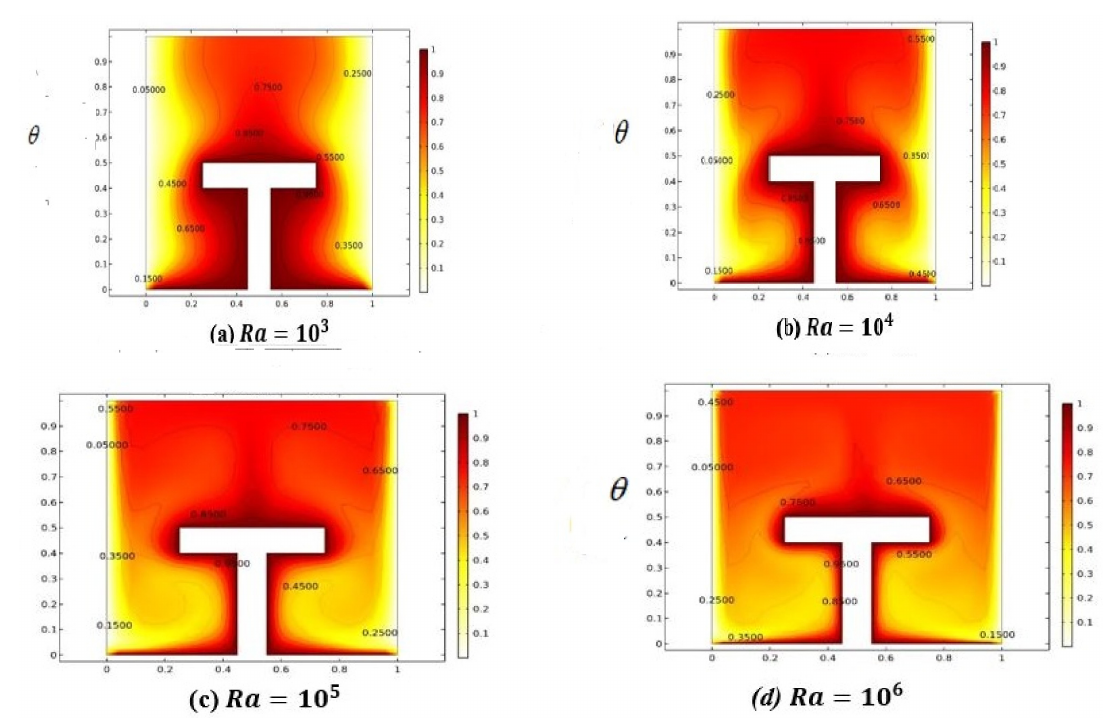
Figure 8. Variation in temperature distribution against ( Ra